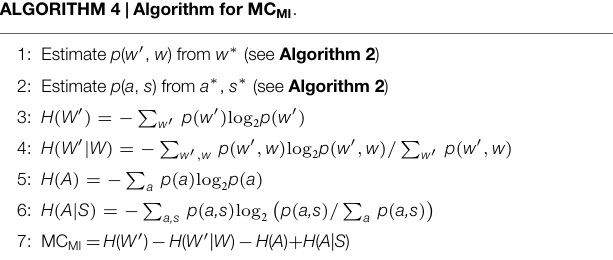
ALGORITHM 4 | Algorithm for MC MI .